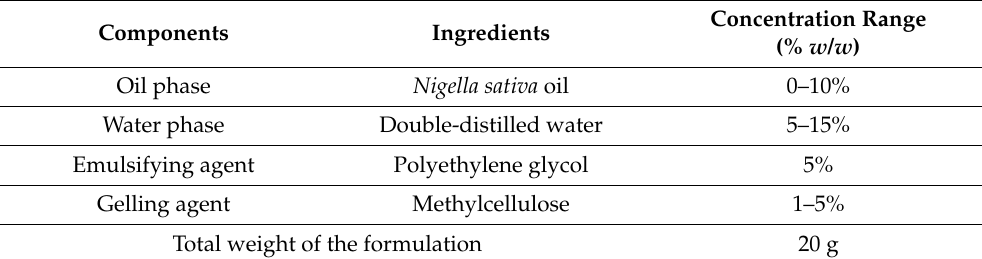
Table 1. Ingredients used in NSO nanoemulgel formulation development.